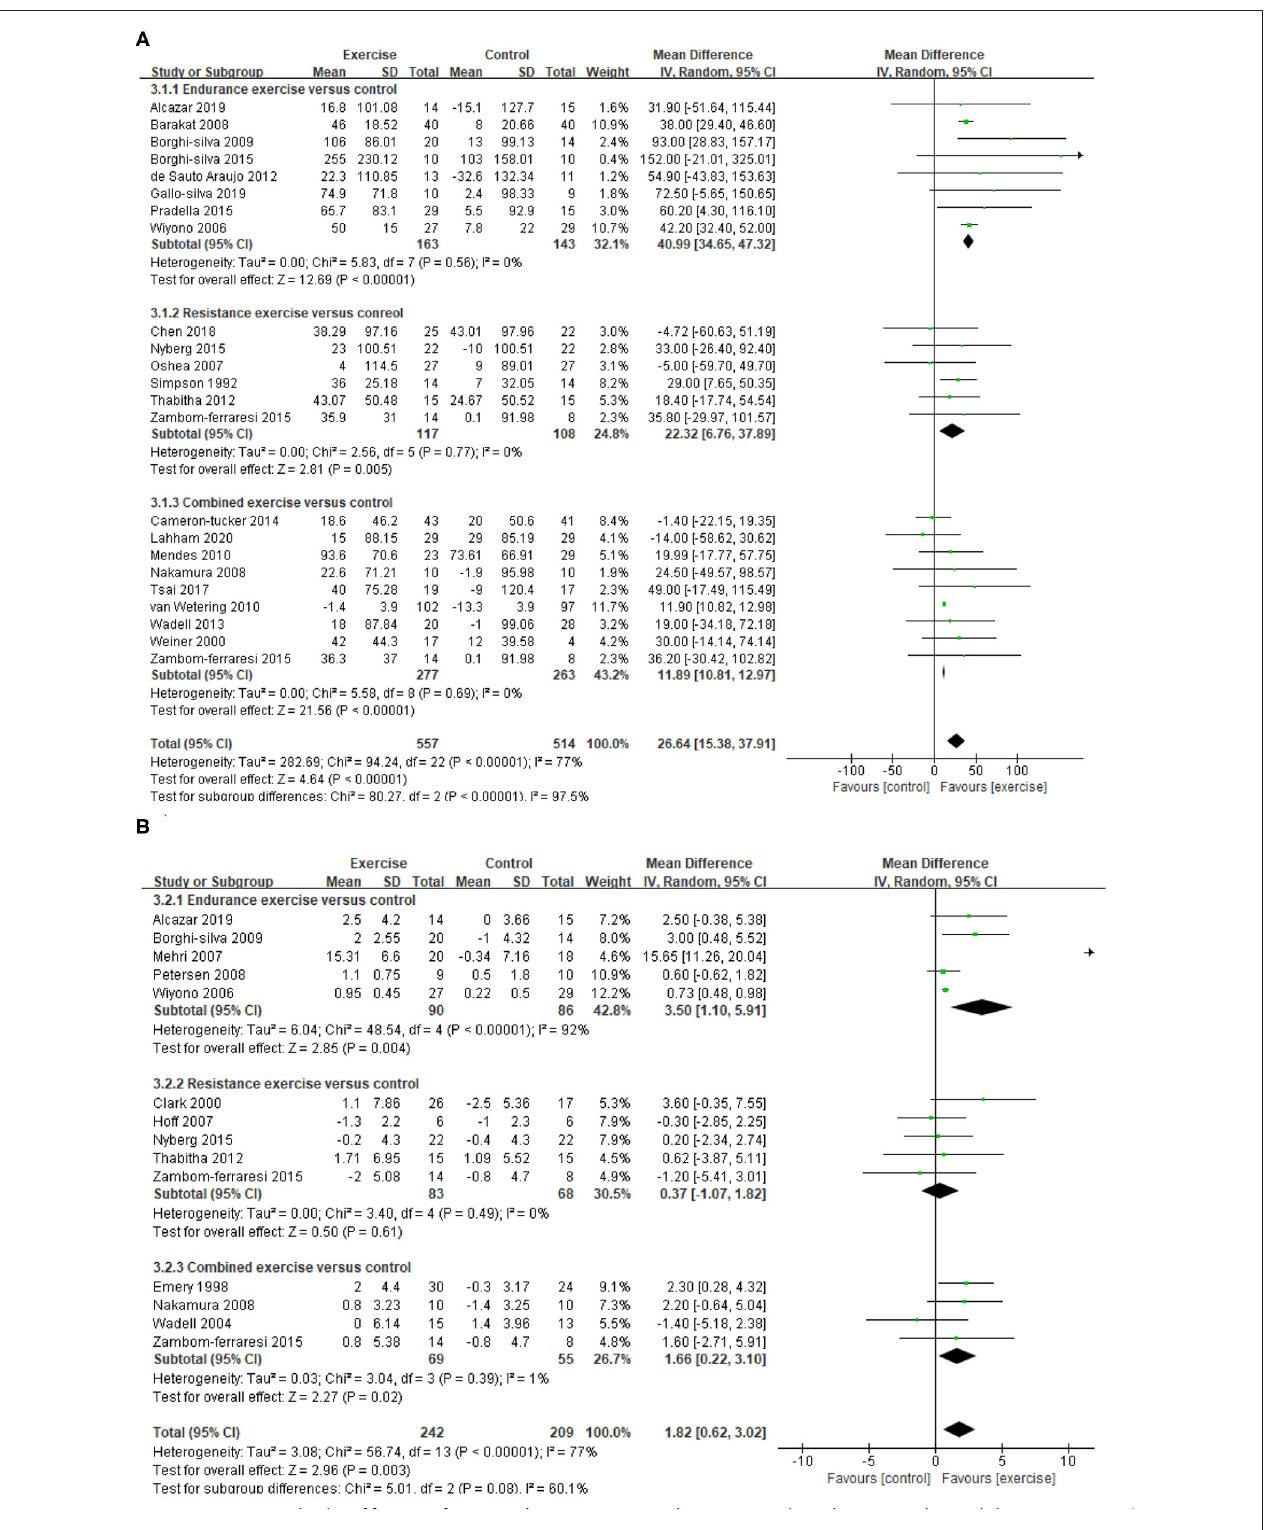
FIGURE 5 | Pooled effect of exercise on exercise capacity in people with COPD. (A) 6MWD, (B) VO 2peak . 6MWD, 6-min walking distance (m); CI, confidence interval; COPD, chronic obstructive pulmonary disease; SD, standard deviation; VO 2peak , peak oxygen consumption (ml/kg/min).